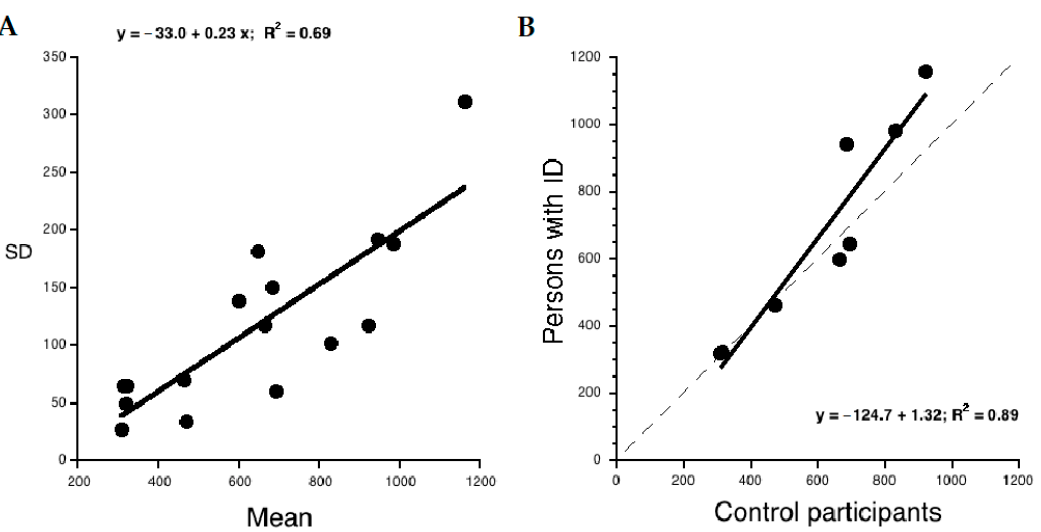
Figure 2. ( A ) Standard deviations (SD) across individuals for each group and the experimental conditions of the Attention and Concentration Battery [54] that yield RT measures are plotted as a function of the corresponding means. The equation of the linear regression is also reported. ( B ) Brinley plot reporting mean RTs for individuals with ID and controls in various conditions. The dashed line indicates equal performance between the two groups. The equation of the linear regression is also reported.